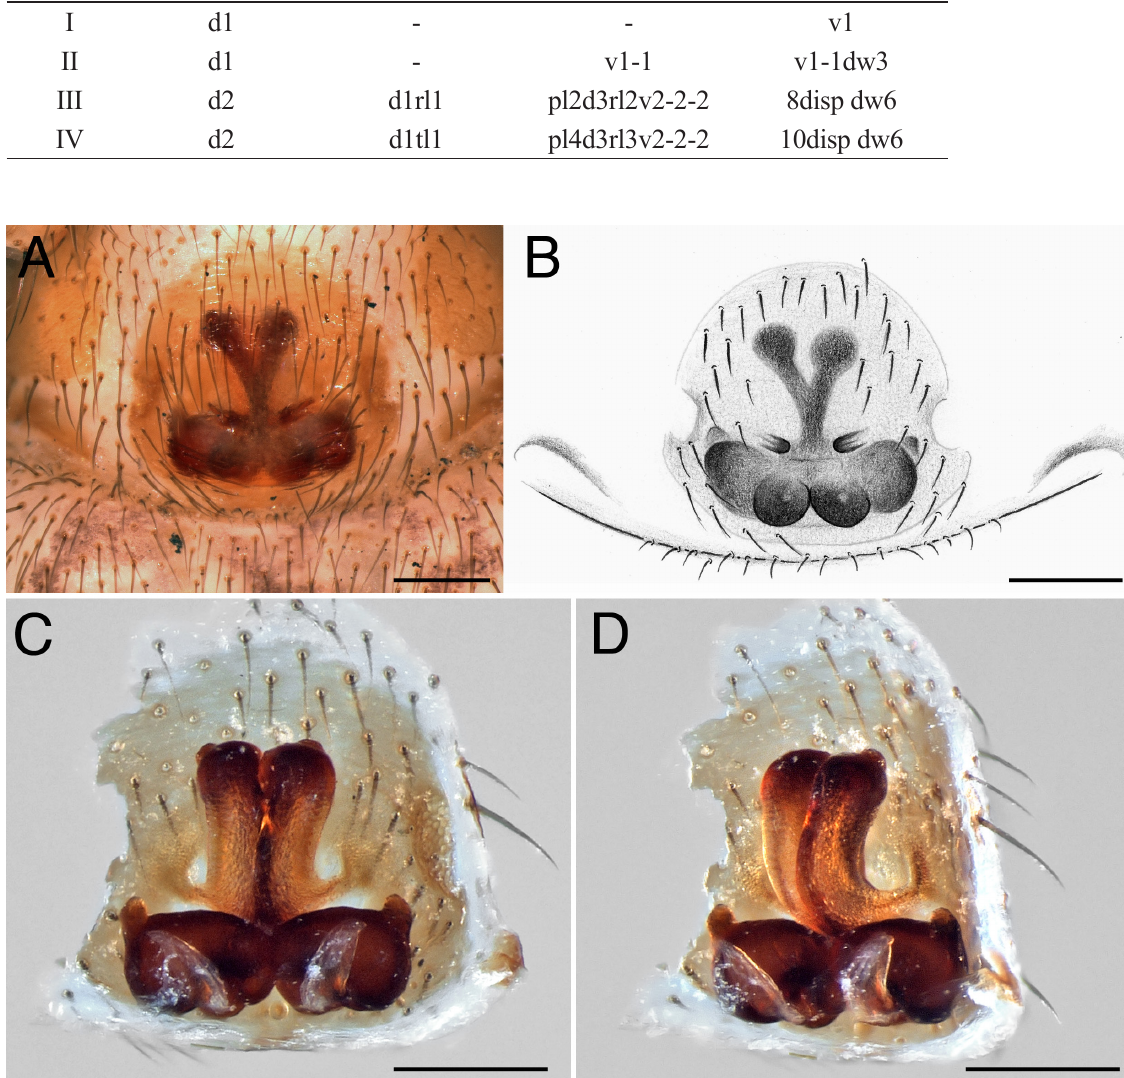
Fig. 10. Ballomma legala gen. et sp. nov. Holotype, ♀. A . epigyne, ventral view. B . As preceding, ventral view. C . epigyne, digested, dorsal view. D . As preceding, dorsolateral view. Scale bars: 0.2